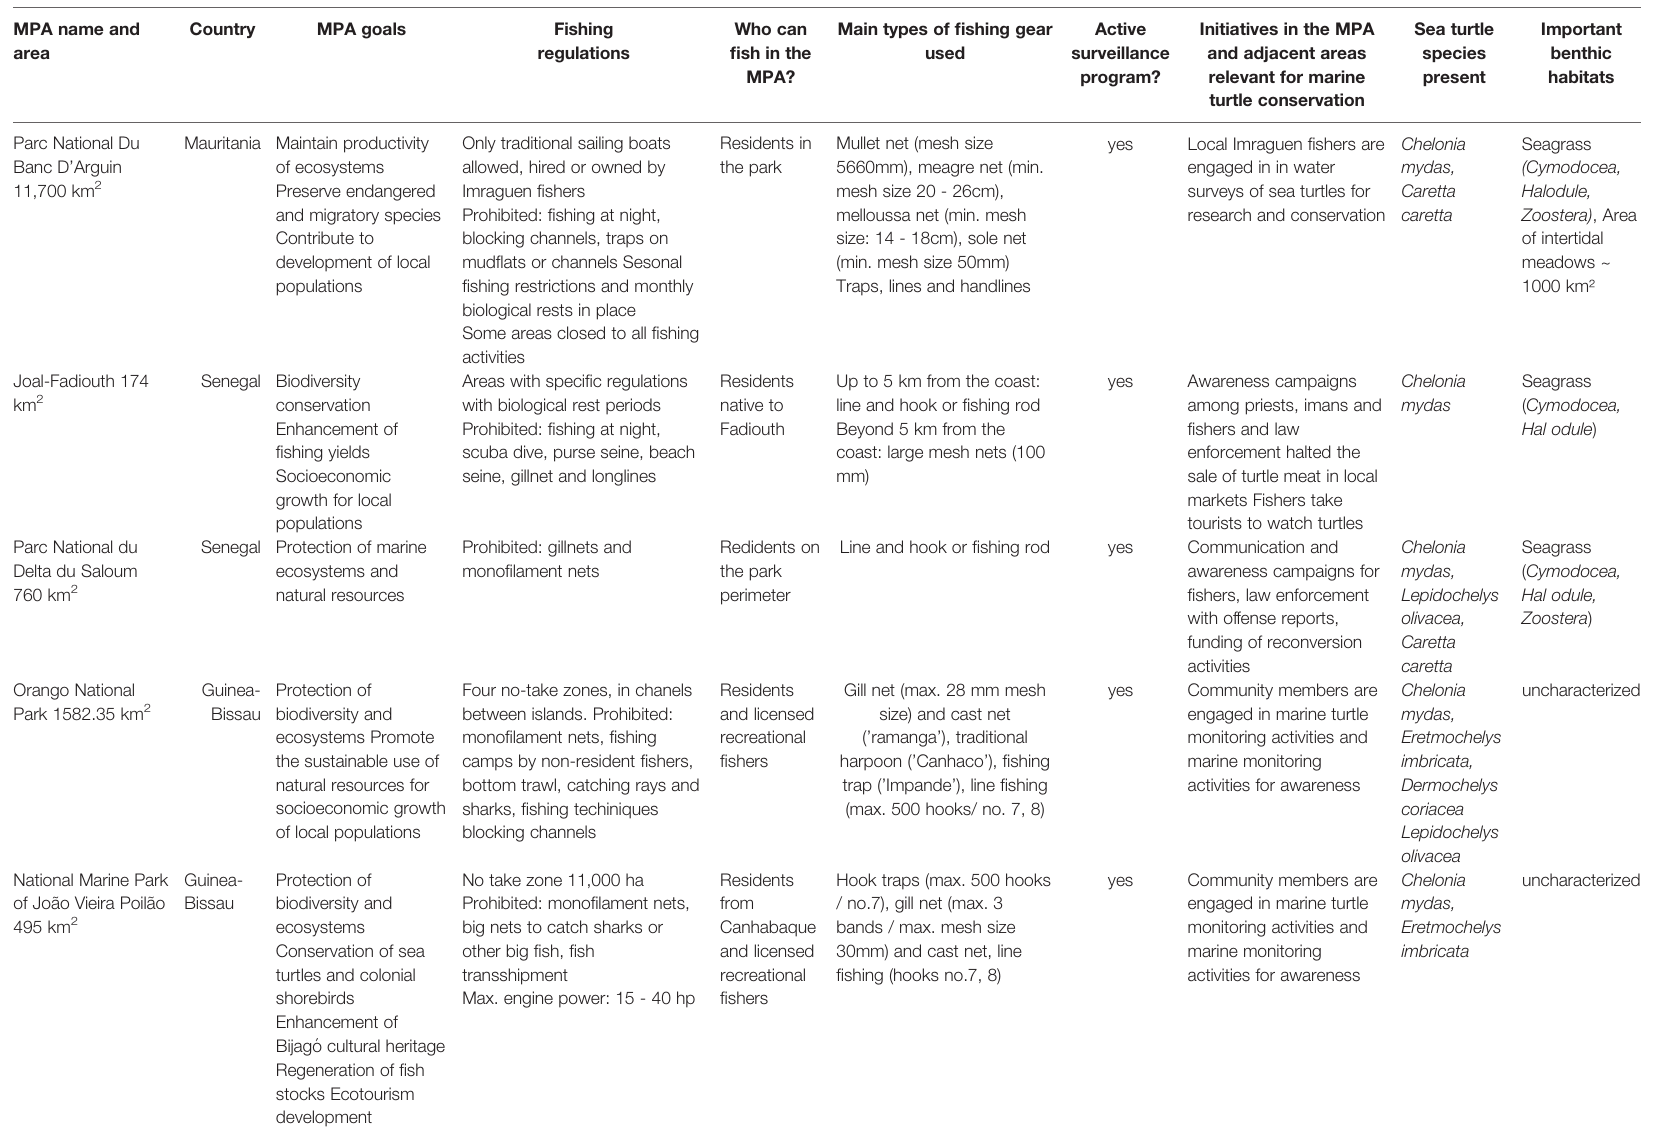
TABLE 2 | Summary of relevant management characteristics of fi ve marine protected areas (MPAs) of the West Africa MPA network (RAMPAO), used by the green turtle population breeding in the Bijago ́ s Archipelago,